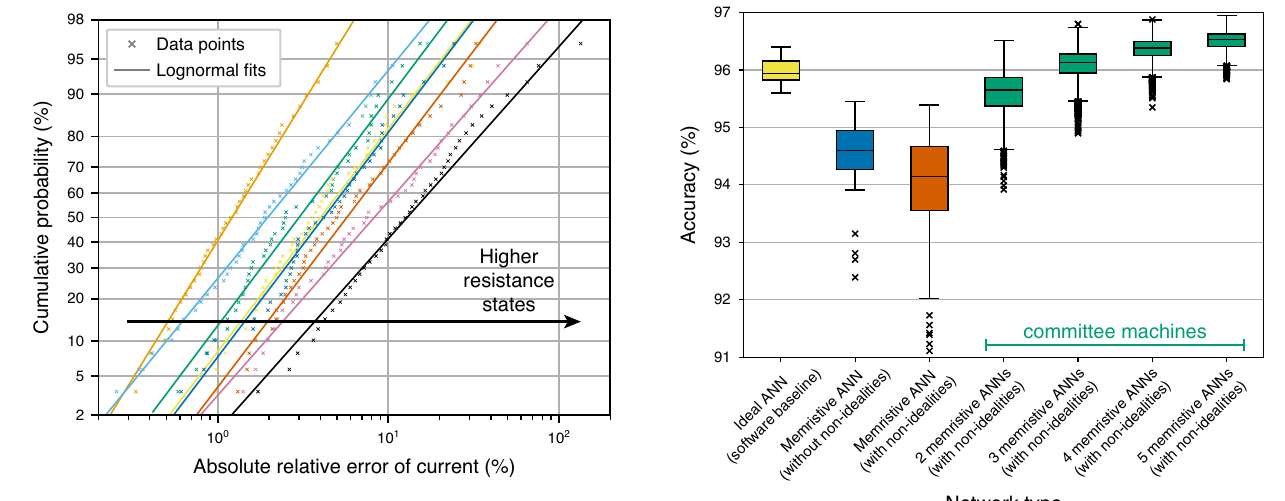
Fig. 5 Random telegraph noise in a Ta 2 O 5 device. Cumulative probability plots of RTN-induced relative current deviations for all eight resistance states of a Ta 2 O 5 RRAM device. Lognormal fi ts are shown for each resistance state.